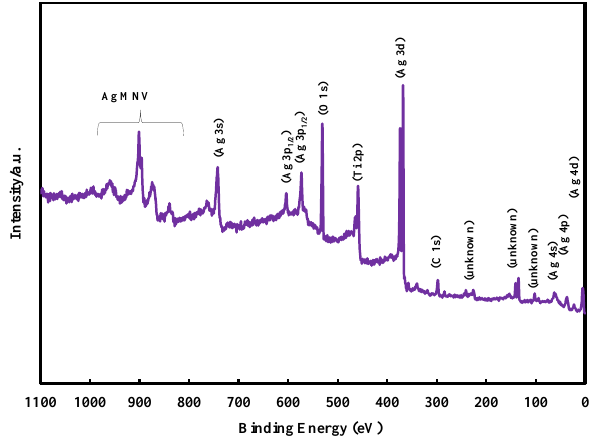
Figure 1. Representative wide-scan XPS survey spectrum taken from the surface of COMP-Ag50 composite thin